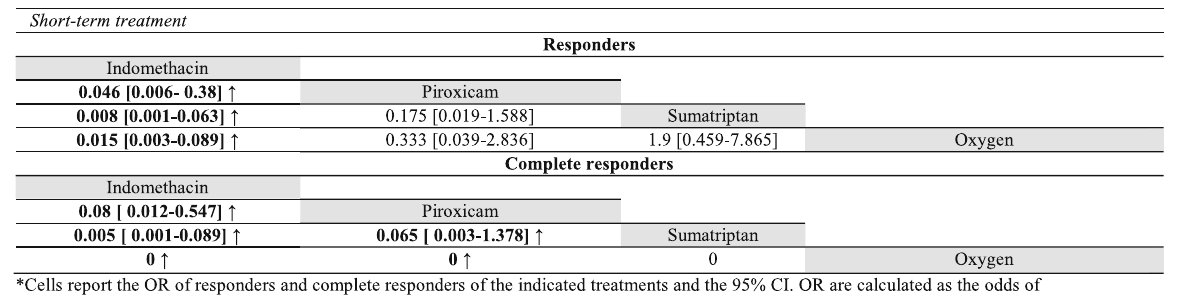
Table 4 statistical comparisons between the odds of responders and complete responders of acute treatments for PH*